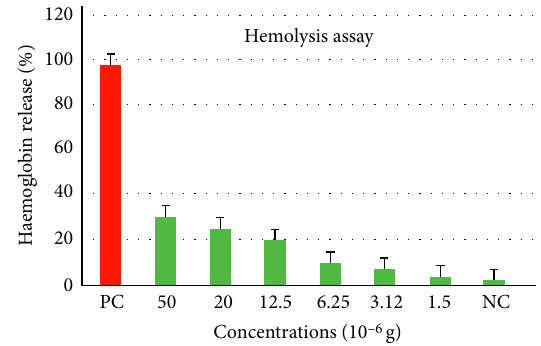
Figure 11: Hemolysis study of CS-NPs coated TiO exposure to RBCs of human blood. Key: PC. Positive control, NC. Negative control.